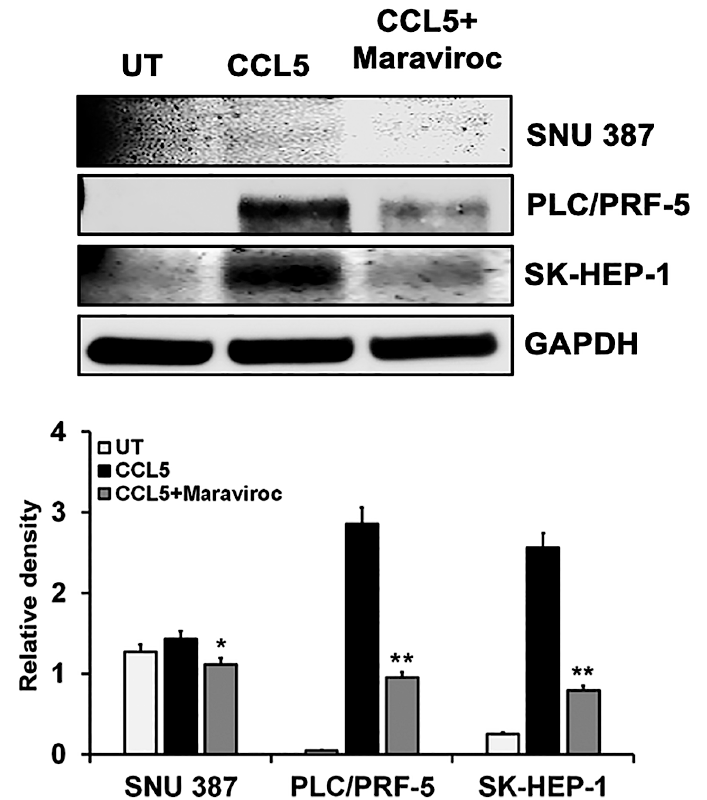
Figure 4. Western blot expression of CCR5 in HCC cells is induced by CCL5. HCC cells were treated with CCL5 with or without maraviroc for 30 min, and the expression of the CCR5 protein was analyzed by immunoblots. The house-keeping marker (GAPDH) was used as a loading control. The immunoblots shown are representative of three independent experiments. Densitometric evaluations of the proteins are shown in the lower panel. Data, presented as means (± standard error), were analyzed by Student’s t -test. ** and * indicate p values ≤ 0.01 and 0.05, respectively.